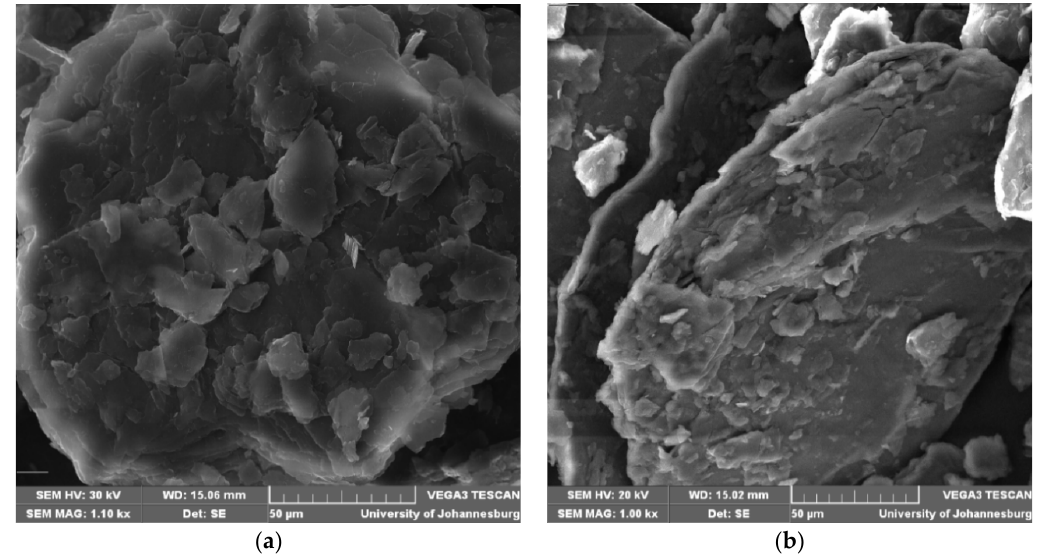
Figure 4. SEM of HDTMA-VMT 0.2M before ( a ) and after ( b ) fluoride sorption.